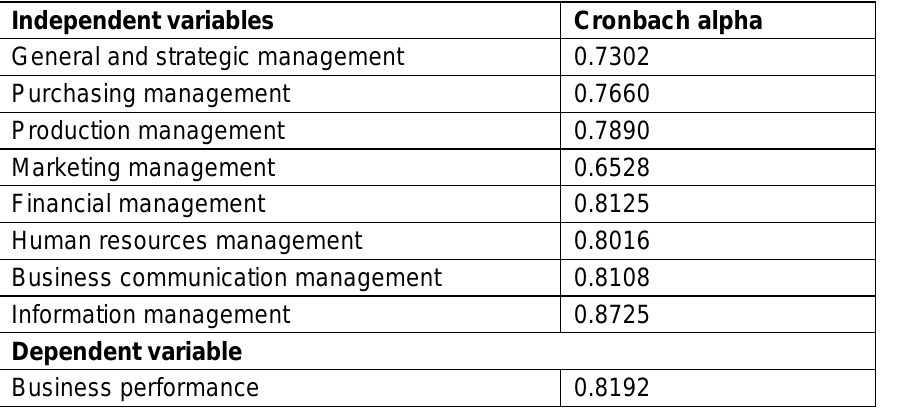
Table 3: Cronbach alpha correlation coefficients Independent variables